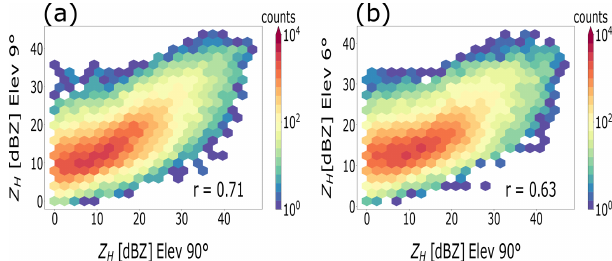
Figure 6. Comparison of VPs and QVPs of Z H generated at two el- evation angles for a collection of stratiform events. Counts indicate the number of points in the hexagon.